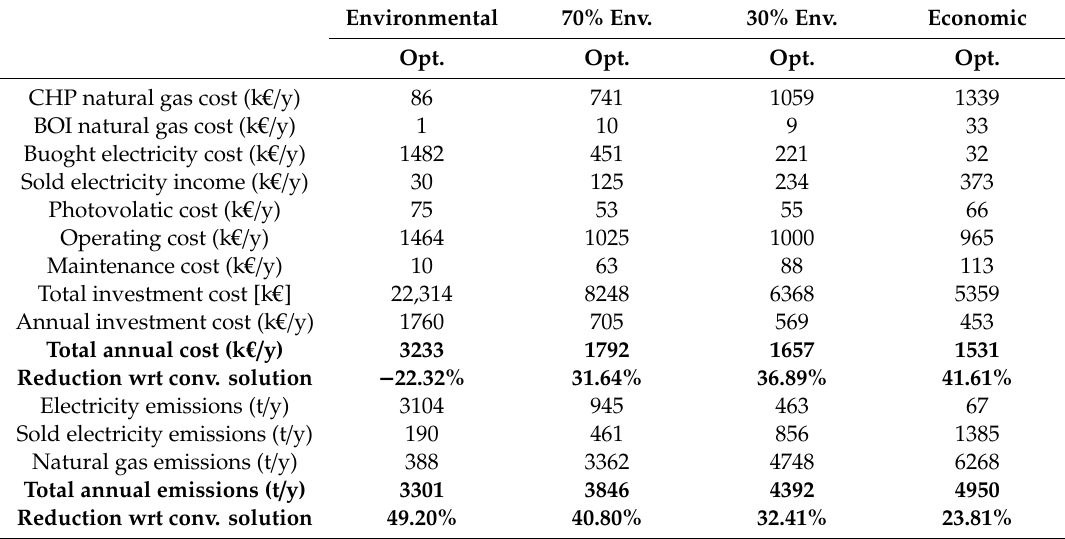
Table 13. Total economic and environmental results of the optimizations—distributed generation solutions integrated with central solar unit. Environmental 70% Env. 30% Env.